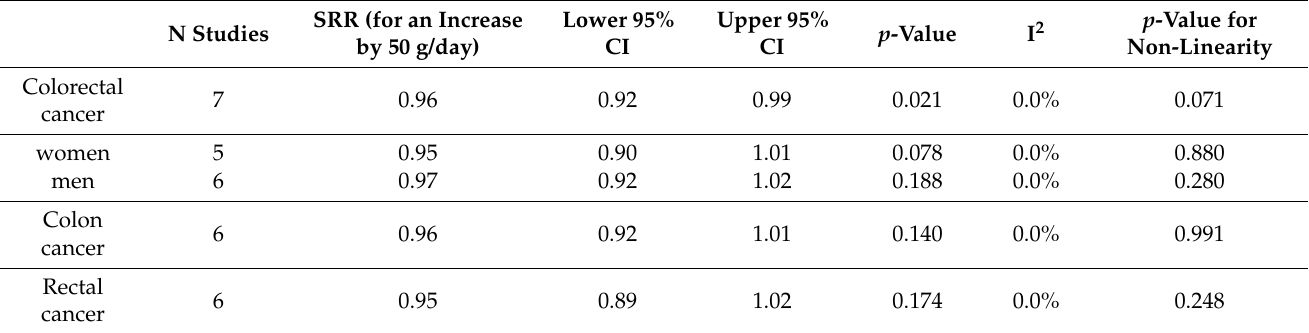
Table 3. Dose–response meta-analysis of studies for the association between fish consumption (linear increment by 50 g/day) and colorectal cancer risk, overall and stratified by tumor site and sex.